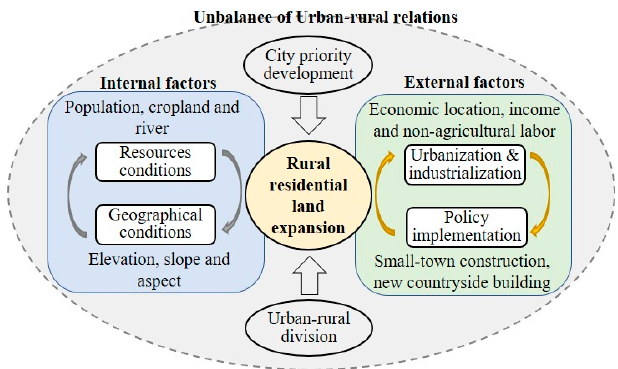
Figure 1. A framework of rural residential land expansion.